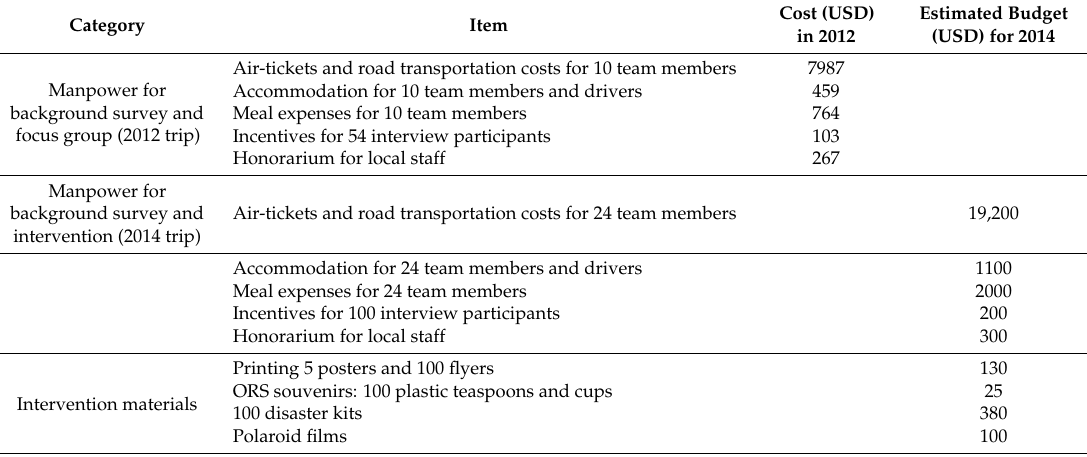
Cost (USD) Estimated Budget in 2012 (USD) for